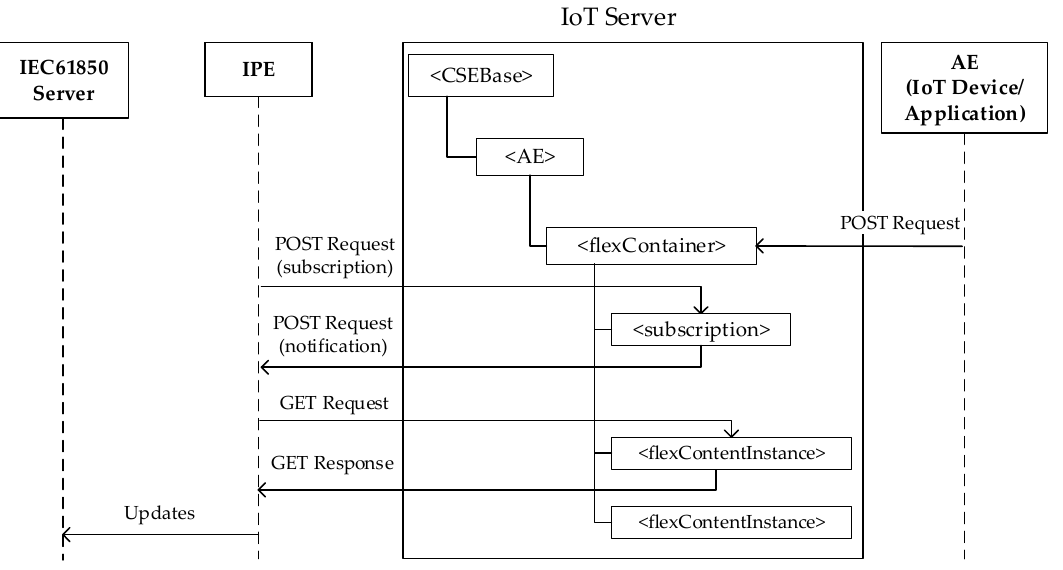
Figure 18. Updating information to IEC 61850 Server.